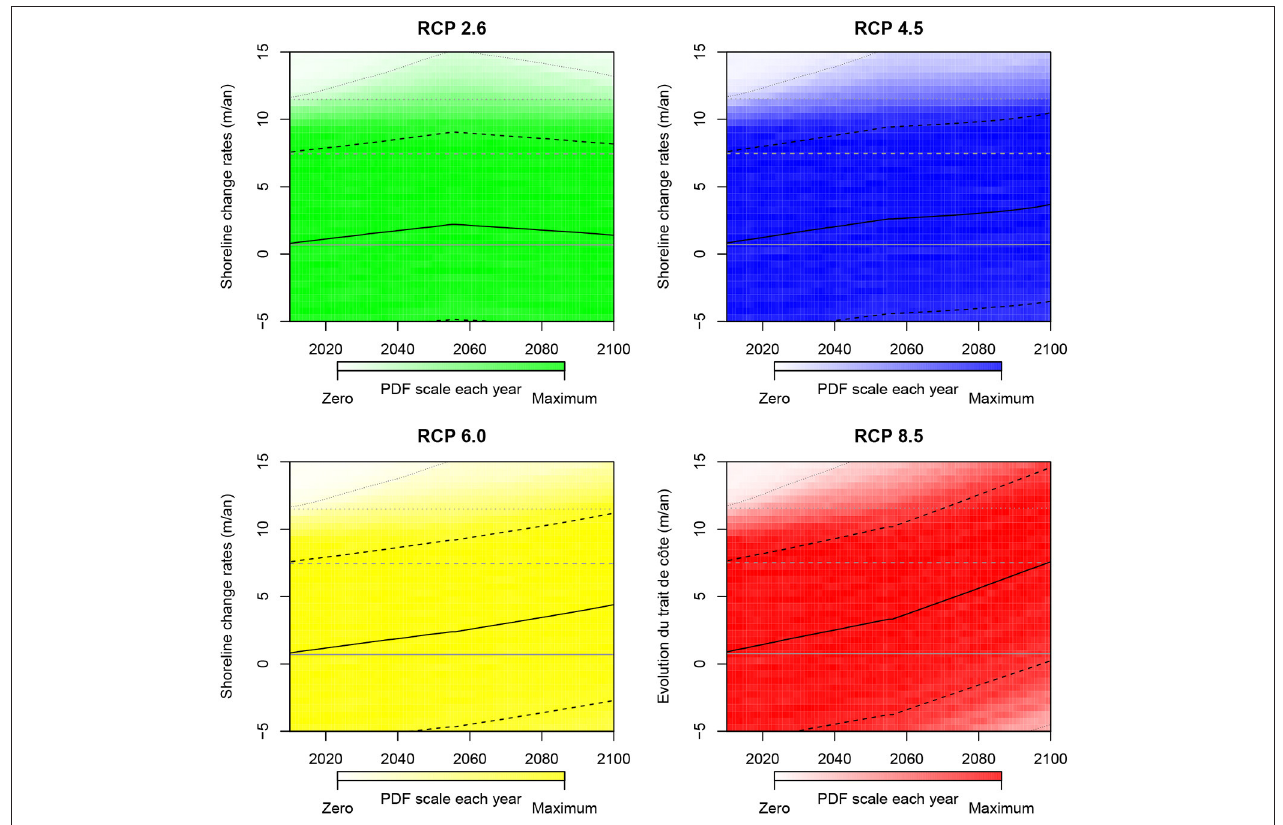
FIGURE 6 | Shoreline change rate projections for the 21st century for high-energy sandy coasts with groins and for different IPCC climate change scenarios. The meaning of gray and black lines is the same as in Figure 3 .